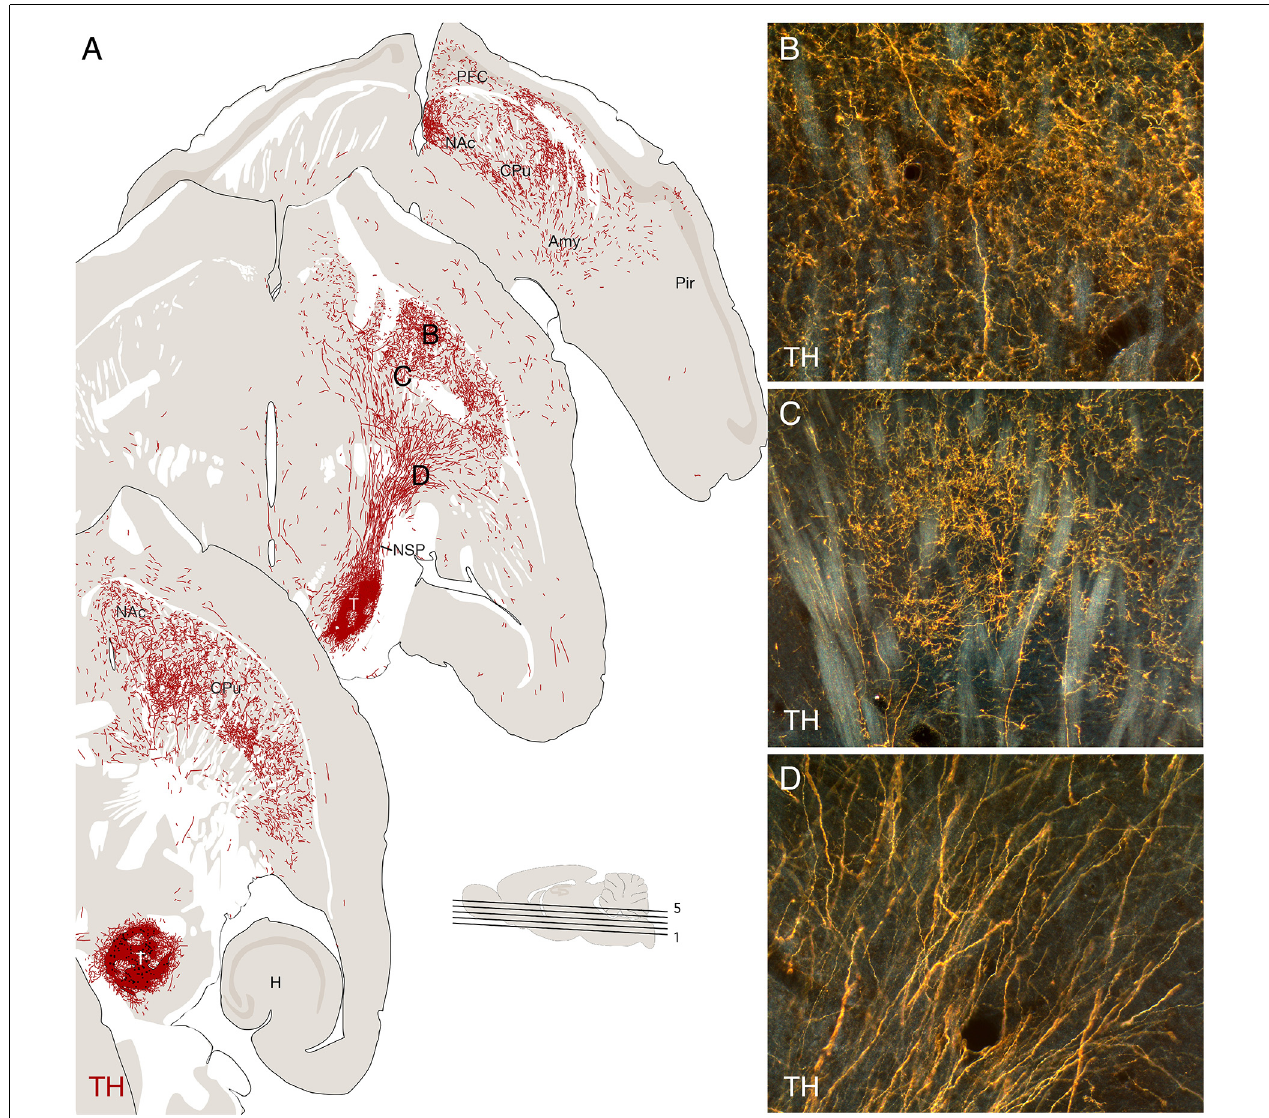
FIGURE 4 | Re-establishment of the nigrostriatal pathway from a transplant of mouse fetal ventral mesencephalic (VM), implanted as a cell suspension in substantia nigra of a 6-OHDA lesioned mouse, 16 weeks post-grafting. The VM tissue was obtained from a transgenic Pitx3-green fluorescent protein (GFP) mouse allowing the outgrowing axons to be visualized using GFP immunostaining, as illustrated in the computer-assisted drawings derived from three horizontal sections in panel (A) . The micrographs in panels (B–D) are taken from the areas marked in panel (A) . Amy, amygdala; CPu, caudate-putamen; H, hippocampus; NAc, nc. Accumbens; NSP, nigrostriatal pathway; Pir, piriform cortex. Modified and redrawn from Thompson et al.